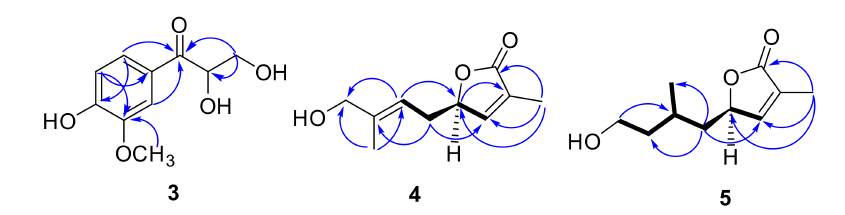
Figure 6. Key HMBC correlations of compounds 3 , 4 and 5 .